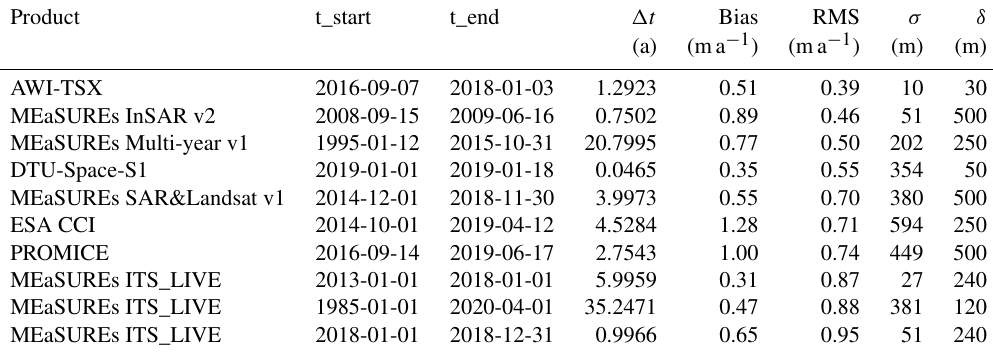
Table 2. The assessment results for the 10 velocity products with the smallest standard deviation (RMS). The products are sorted with increasing RMS. Notice that the AWI-TSX, the DTU-Space-S1, and the MEaSUREs ITS_LIVE products are also among the 10 products with the smallest bias. The velocity bias is determined for both the x - and y -direction (see Supplement, Table S2). The bias listed here is the length of the velocity bias vector, i.e., the average rate of change in distance between poles moving with the satellite-based velocity field compared to poles moving with the GPS velocities. The complete list of assessment results can be found in the Supplement, Table S2. Dates are given in the format